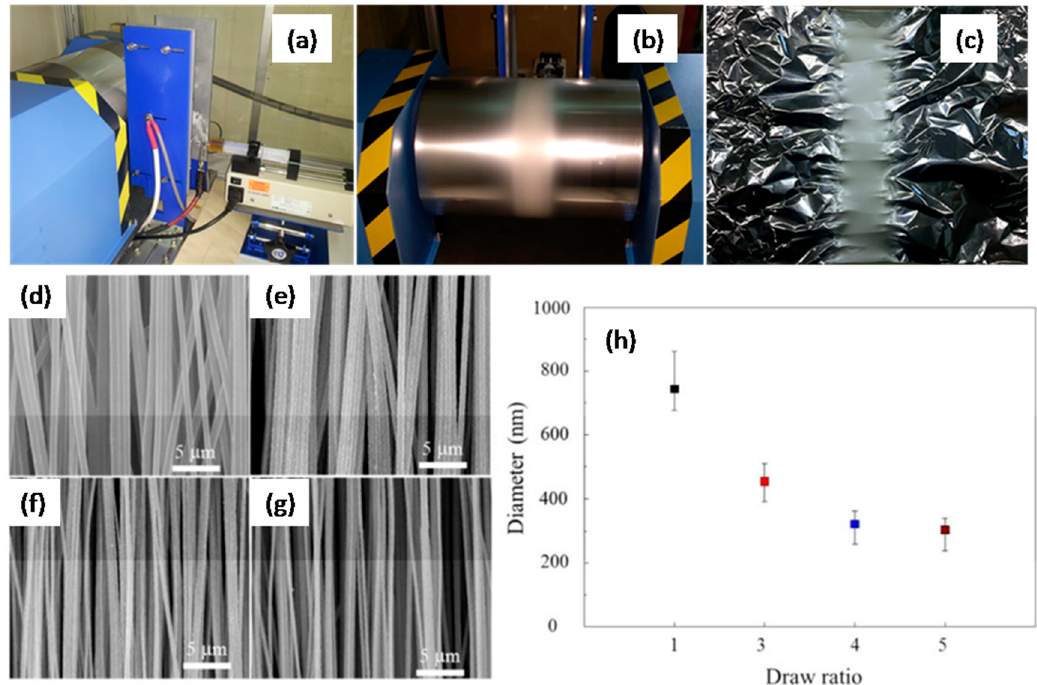
Figure 9. Electrospinning setup ( a ), and collected PAN nanofibers on the rotating drum with alignment to one direction ( b , c ). SEM images of aligned and drawn PAN-NFs with different draw ratio ( d ) 1 (as-electrospun), ( e ) 3, ( f ) 4, and ( g ) 5. ( h ) Variation of fiber diameter as a function of stretch ratio.